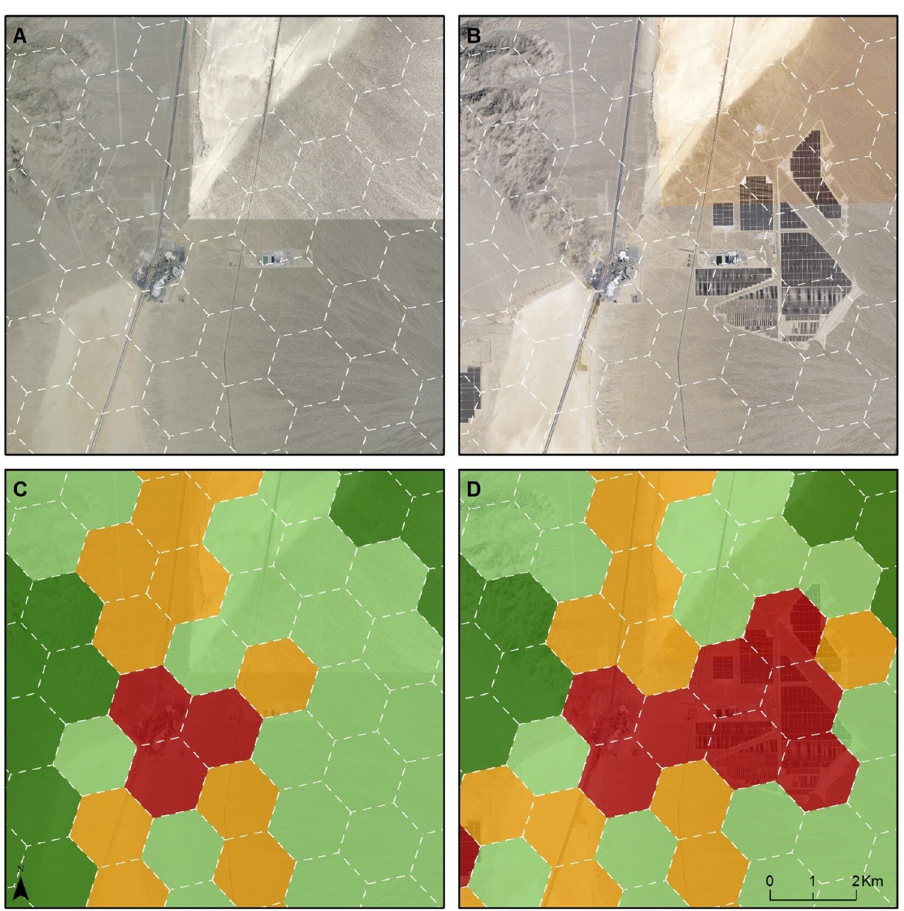
Fig 4. A second example of change in conservation value in Ivanpah Valley Due to solar energy development. A: 2009 imagery; B: 2016 imagery; C: Conservation Value in 2009; D: Conservation Value in 2017. The four colors shown on maps C and D (dark green, light green, orange, and red) correspond with the conservation value categories defined in Table